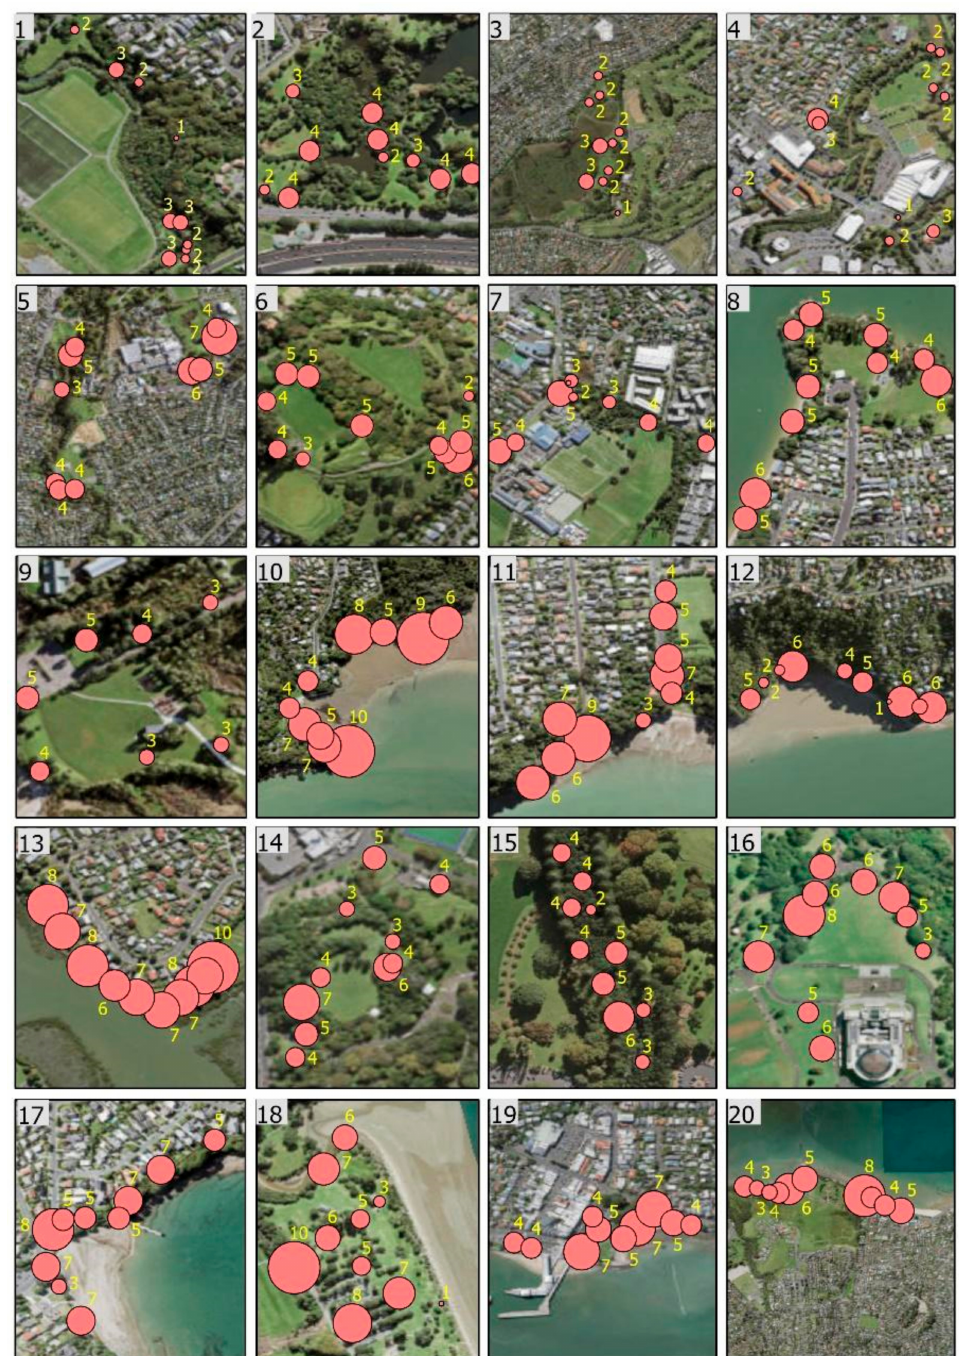
Figure 3. Lichen species count per tree from the 20 sampling